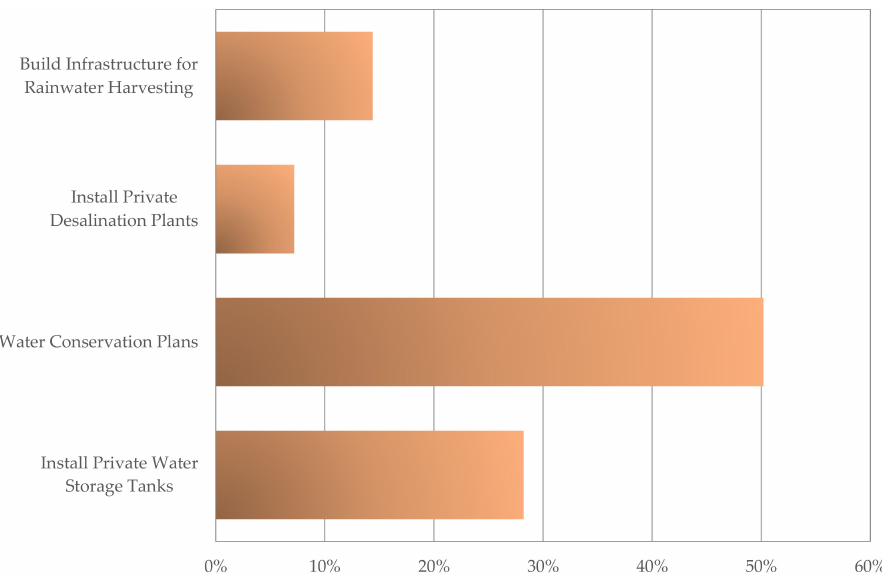
Figure 7. Respondents’ Perceptions: their policies, strategies, or plans to guarantee water sup- ply